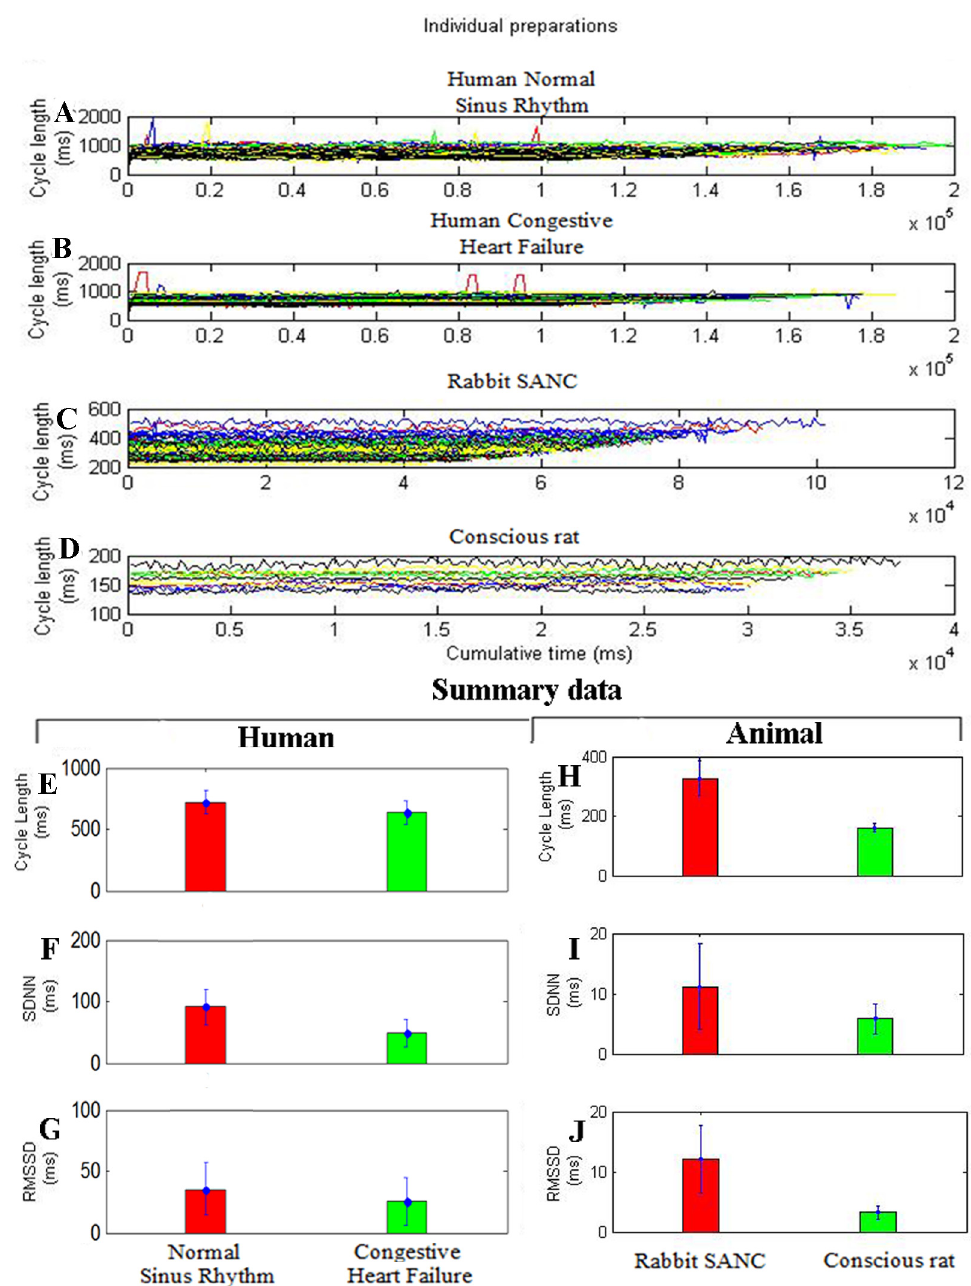
Fig 1. Differences in heart rate variability (HRV) among different cardiac preparations (baseline conditions). A to D, Tachograms from: (a) human normal sinus rhythm (n = 72); (b) human congestive heart failure (n = 44);(c) rabbit SANC(sinoatrial node cell; n = 67);(d) conscious rat(n = 11) subjects. Individual experiments are plotted in unique colours. E to J, Summary of baseline differences in cycle length (CL) and HRV among cardiac preparations. Mean (+SEM) CL (E,H), SD of normal beat to normal beat intervals (SDNN; F,I), and root mean square of successive differences (RMSSD) (G,J) for different preparations.